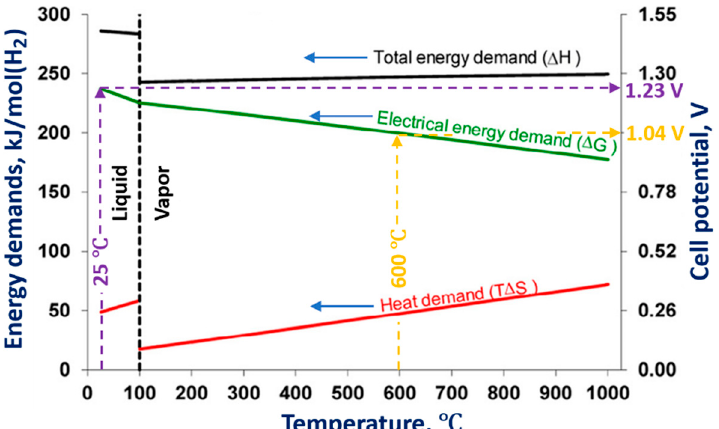
Figure 3. Influence of the temperature of the electrolytic solution on the energy demands for water decomposition. Reprinted from [34] with permission from Elsevier. Changes in the cell potential for 25 °C and 600 °C of the electrolytic solution temperatures are also shown.